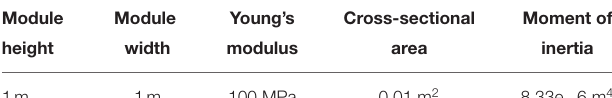
TABLE 1 | Overview of the initially chosen structural properties of the example structure.